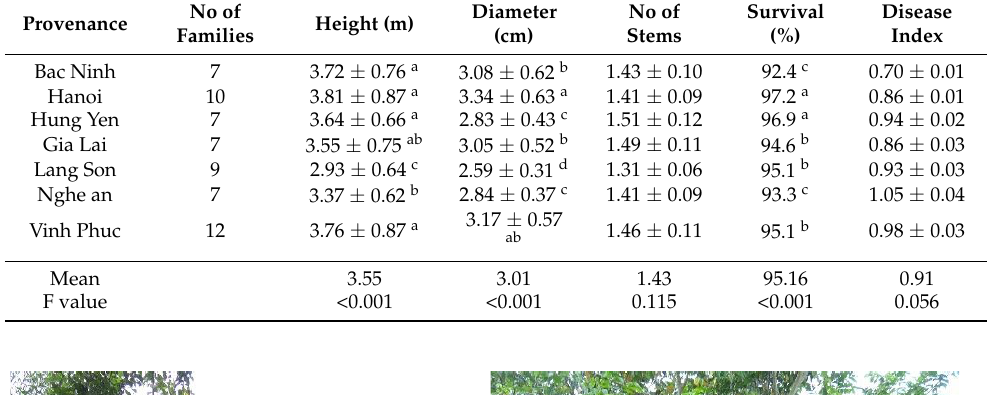
Table 2. Average height, diameter, number of stems, survival, and disease index of Dalbergia tonkinen- sis provenances at 3 years in Doan Hung. Different lowercase letters in a column indicate a significant difference according to DMRT at p < 0.05.